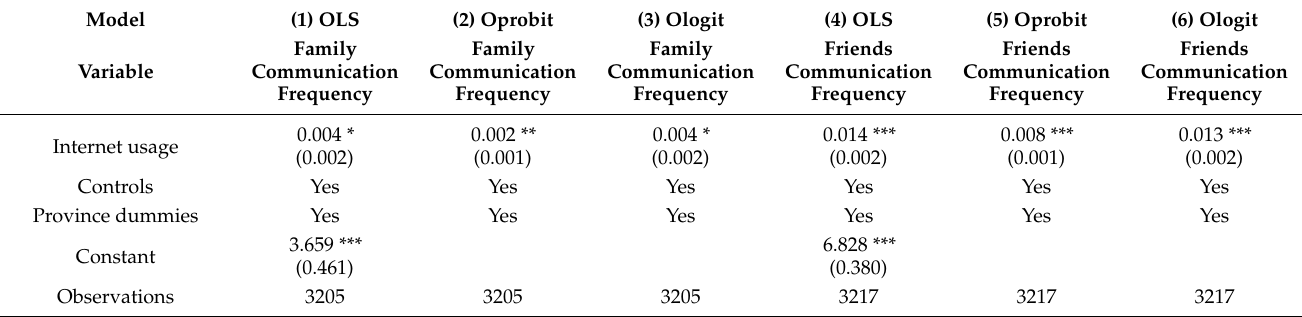
Table 4. Robustness checks, using other indicators of interpersonal